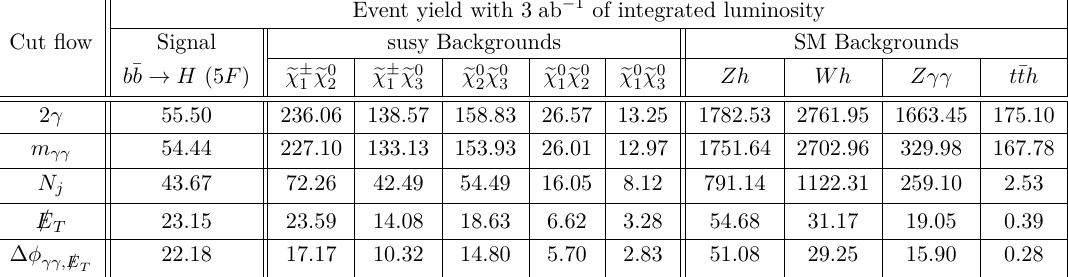
mode with 5F signal T